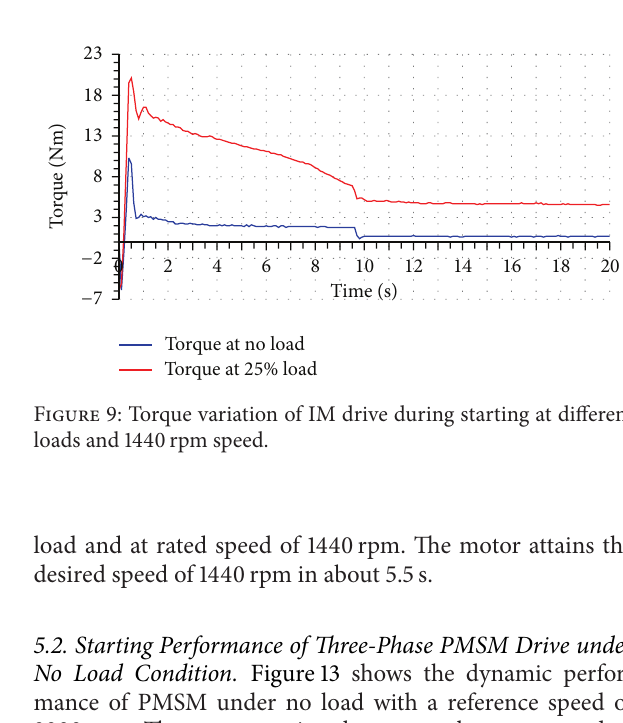
Figure 8: Current variation of IM drive during starting at different loads and 1440rpm speed.